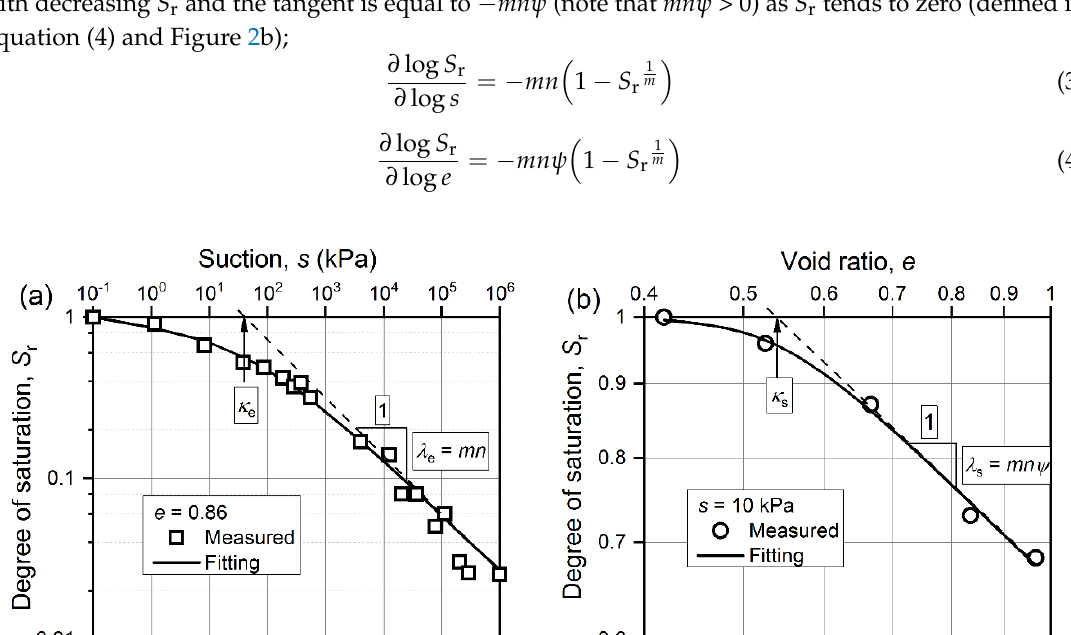
Figure 2. Main drying curves with respective asymptotes (data from Salager et al. [36]): ( a ) on the